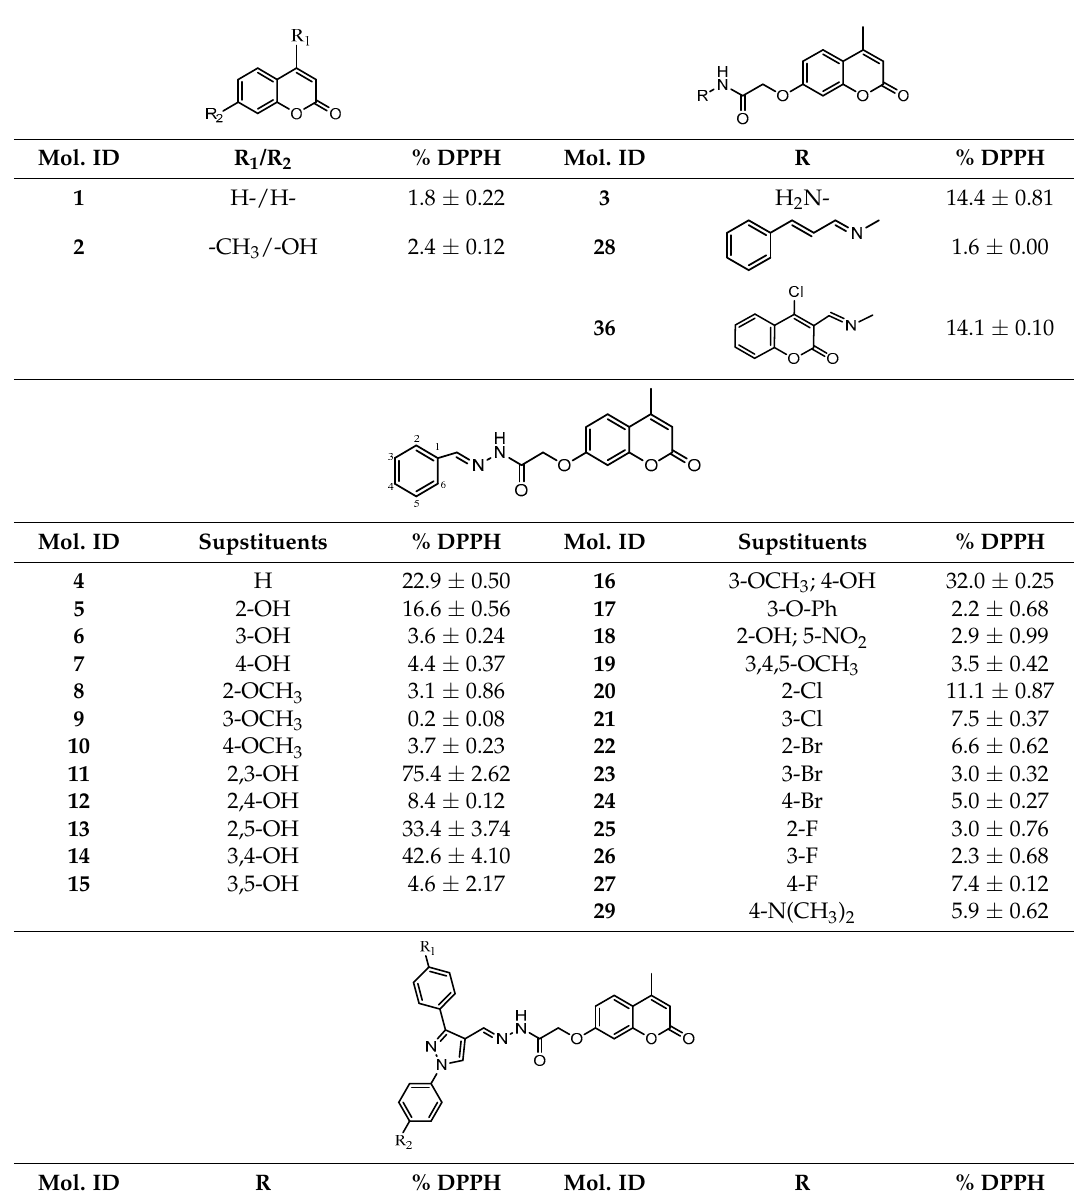
Molecules 2017 , 22 , 1482 Table 1. Structures of analysed compounds with their antioxidant activities (%DPPH) *. Table 1. Structures of analysed compounds with their antioxidant activities (%DPPH) *. Table 1. Structures of analysed compounds with their antioxidant activities (%DPPH) *. Table 1. Structures of analysed compounds with their antioxidant activities (%DPPH) *. Table 1. Structures of analysed compounds with their antioxidant activities (%DPPH) *. Table 1. Structures of analysed compounds with their antioxidant activities (%DPPH) *. Table 1. Structures of analysed compounds with their antioxidant activities (%DPPH) *.